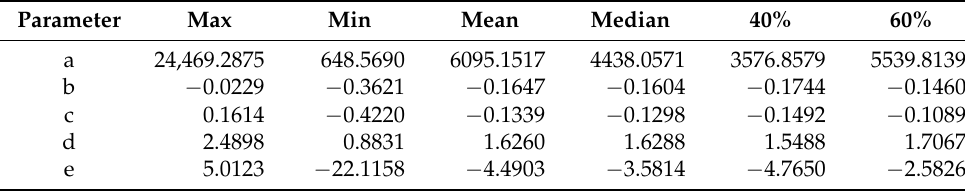
Table 5. Statistics of nonlinear regression coefficients. Table 4. Result of complex data analysis.